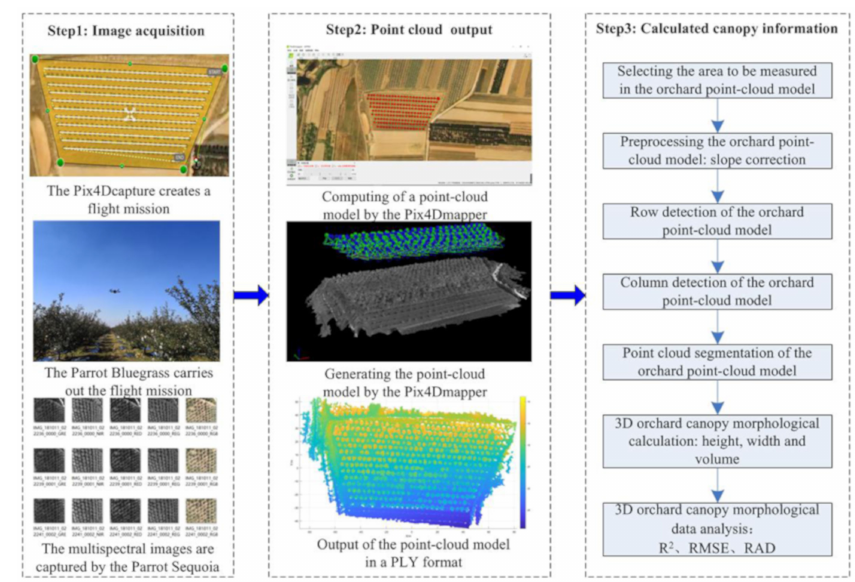
Figure 1. Operating principle of the UAV canopy photogrammetry system for modern standard